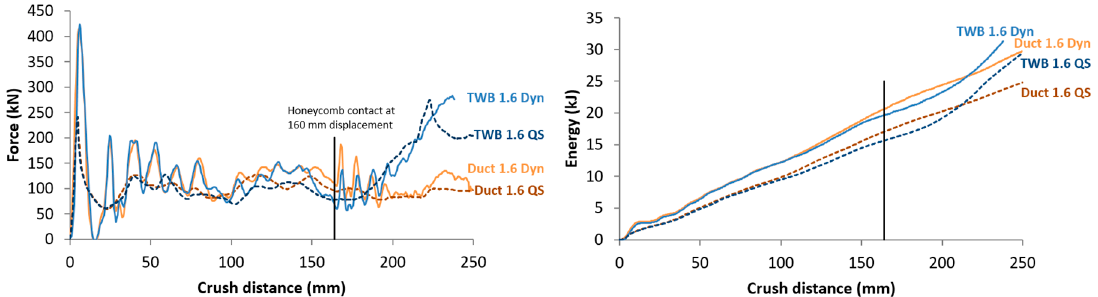
Figure 4. Comparison of crush response under dynamic (Dyn) and quasi-static (QS) conditions.